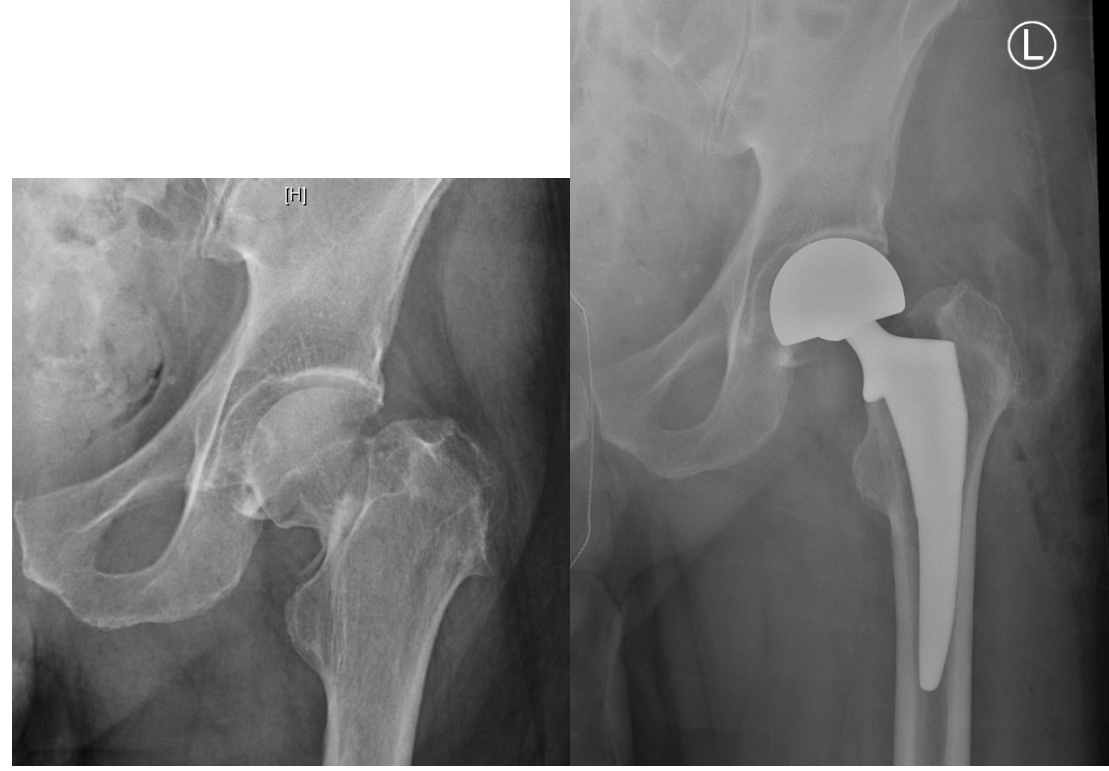
Figure 3. Example radiographs demonstrating total hip arthroplasty Garden III fracture (Left: Preoperative, right: Postoperative).